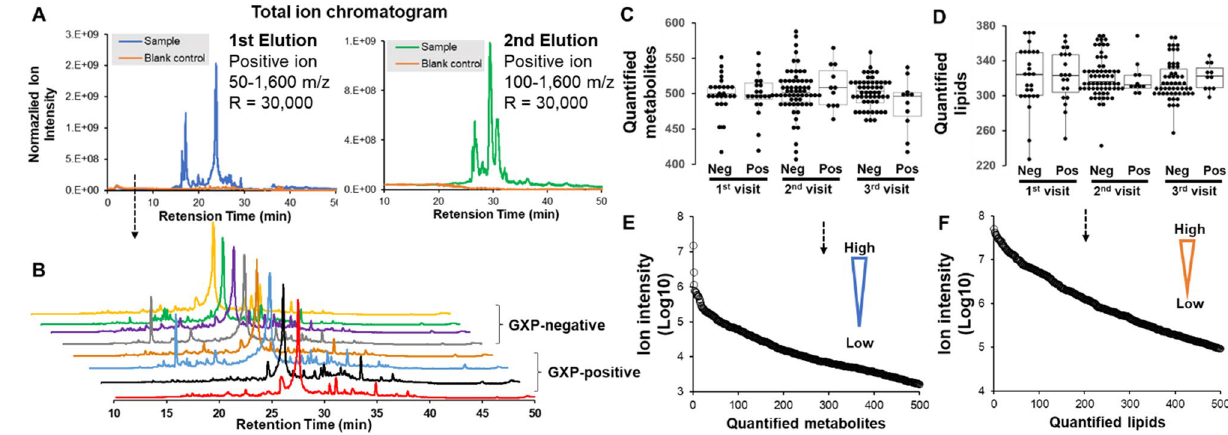
Figure 3. Overview of molecular profiles of EBA samples with liquid chromatography and high-resolution MS. ( A ) Total ion chromatograms of control samples and EBA samples. ( B ) Representative total ion chromatograms of small metabolites from GXP-positive and GXP-negative participants. ( C ) Feature distributions of small metabolites from three visits of GXP-positive and GXP-negative participants. ( D ) Feature distributions of lipids in three visits of GXP-positive and GXP-negative participants. ( E ) Dynamic range of small metabolites detected across all study participants. ( F ) Dynamic range of lipids detected across all study participants.